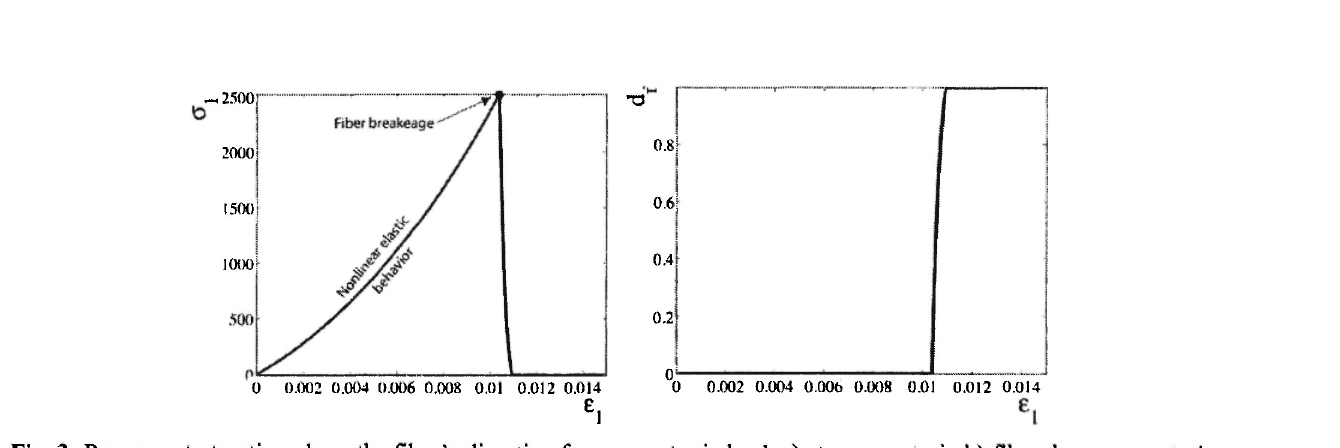
Fig. 3: Response to traction along the fiber's direction for a monotonic load, a) stress vs. strain b) fiber damage vs. strain